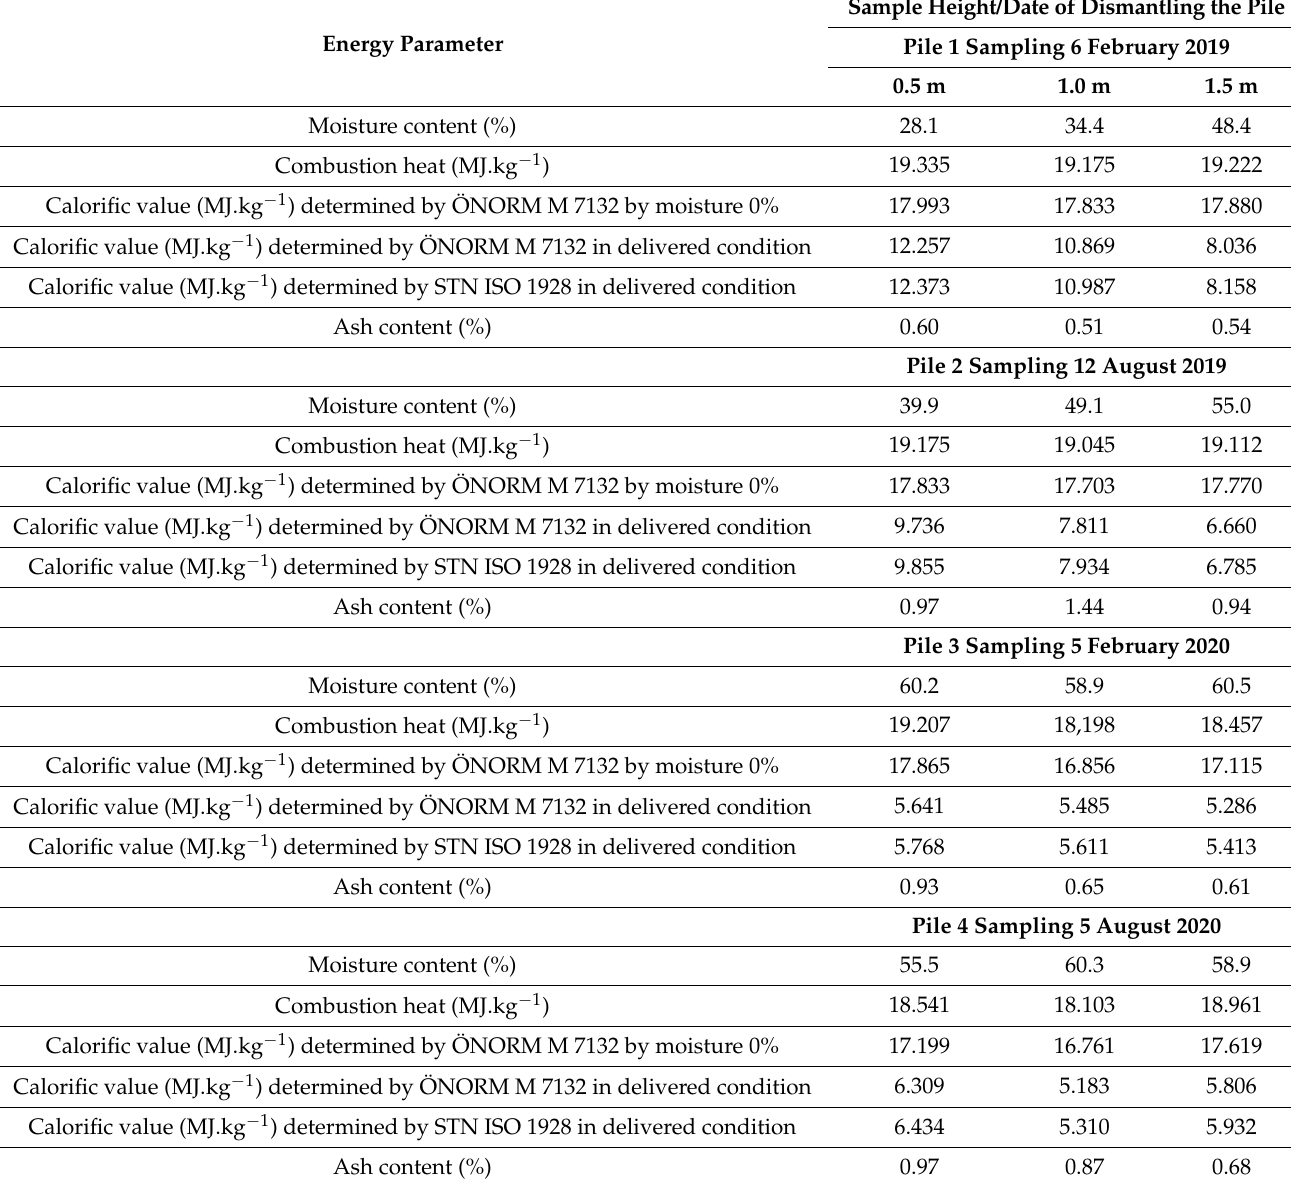
Table 1. Overview of energy parameters of wood chips taken from three height levels from the experimental